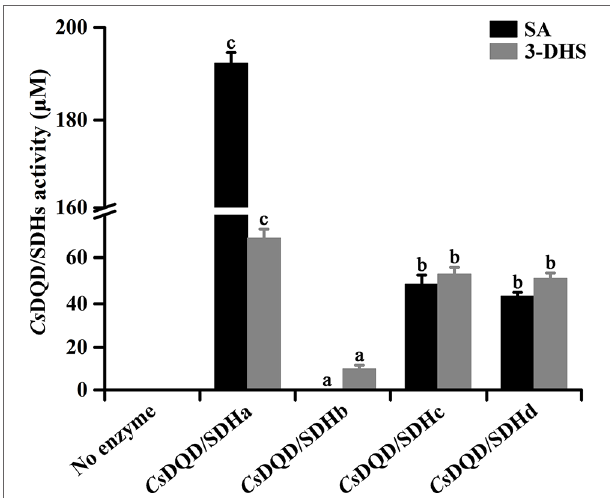
FIGURE 3 | Quantification of 3-DHS and SA production catalyzed by recombinant Cs DQD/SDHs in vitro . The reaction products in enzymatic assays were quantified using HPLC ( λ 3-DHS = 234 nm, λ SA = 211 nm). Data are shown as the mean of three replicates ± SD. Different letters represent statistically differ at P < 0.05 according to one-way ANOVA of Duncan’s test. 3-DHS, 3-dehydroshikimate; SA, shikimate; HPLC, high-performance liquid chromatography; ANOVA, analysis of